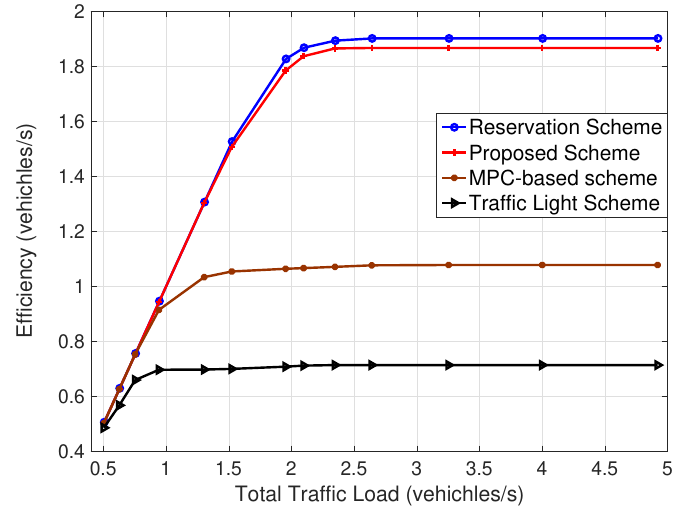
Figure 5. Traffic efficiency comparison under different